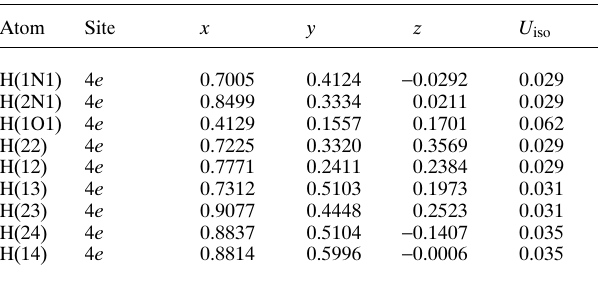
Table 2. Atomic coordinates and displacement parameters (in Å 2 )